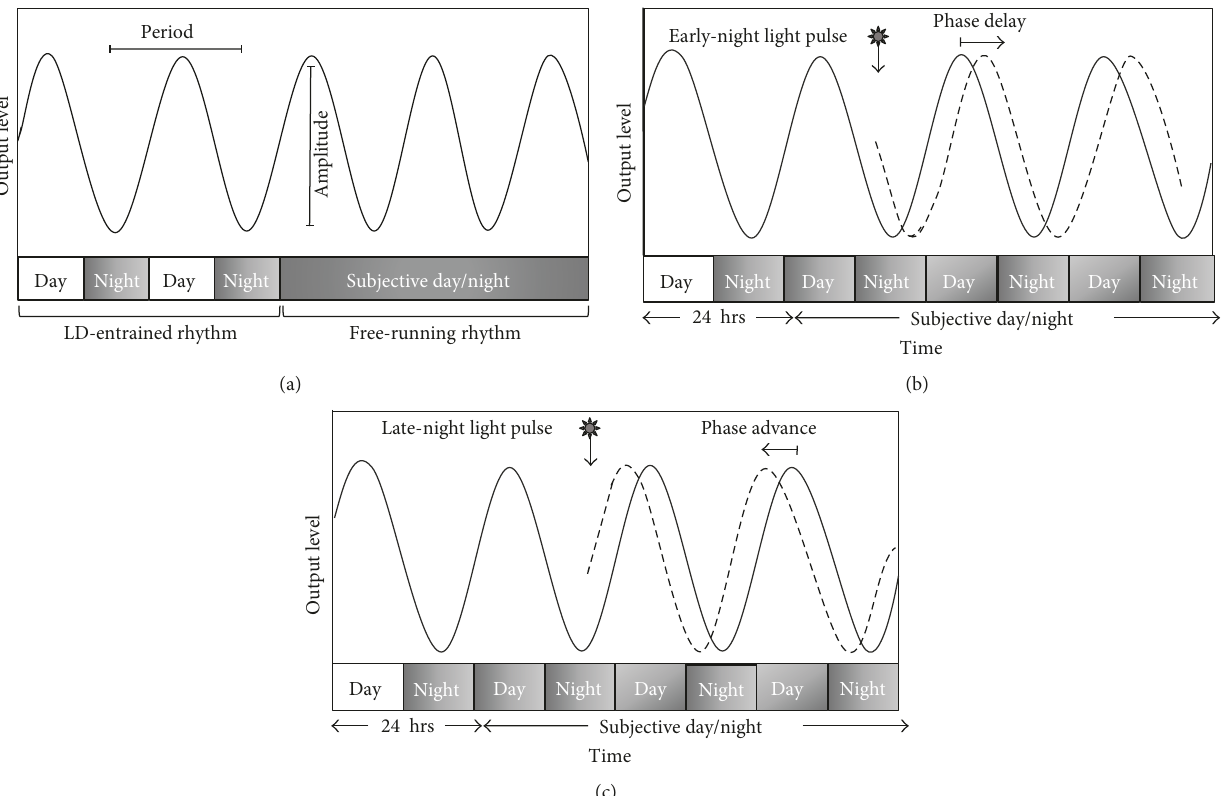
Figure 1: Measures of the circadian rhythm. (a) Cycles of peaks and troughs of activity occur at approximately 24-hour intervals. The period of the cycle is the time between successive peaks (or troughs) of activity whereas the extent of the increase or decrease in activity represents the amplitude of the cycle. (b) An early-night light pulse results in a phase delay. (c) A late-night light pulse results in a phase advance.